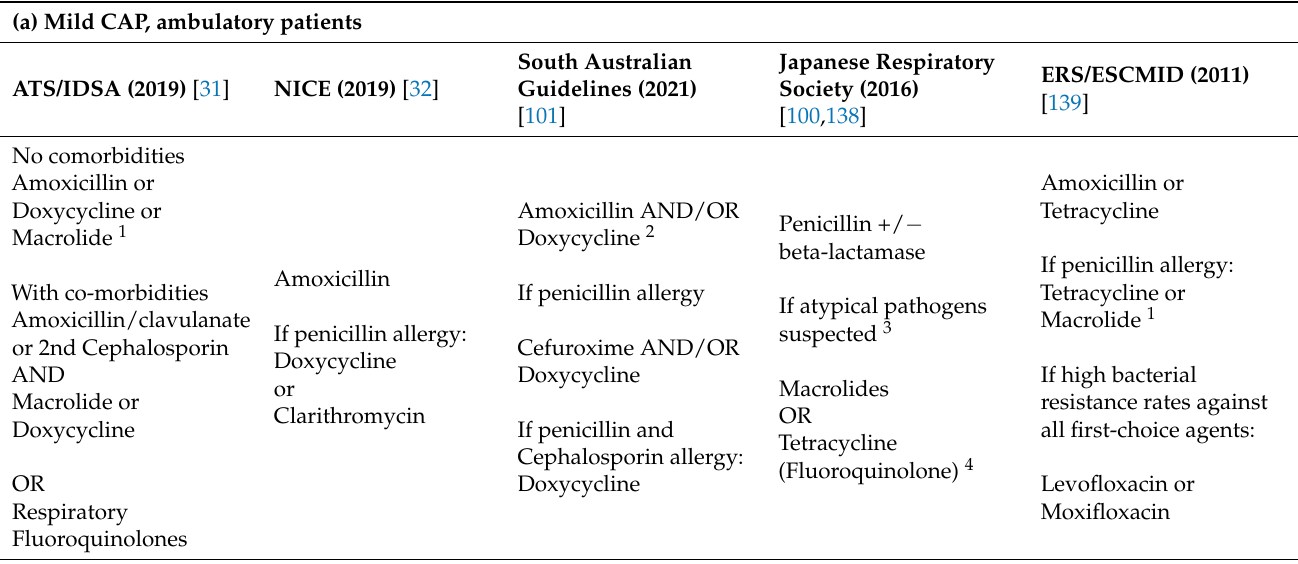
Table 2. Comparison of some international guidelines with regard to atypical coverage. Recommen- dations specific to atypical coverage are in bold